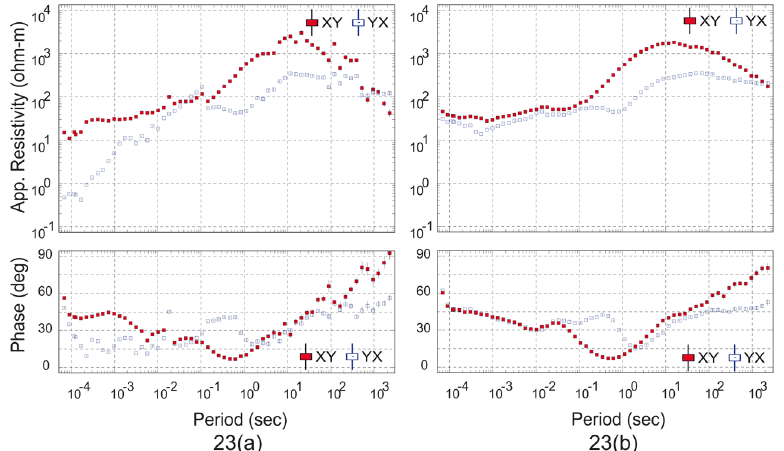
Figure 23. Comparison between processing approaches that are applied on broad band MT data of site K11 from Koyna profile. (a) Result (apparent resistivity (top panel) and phase (bottom panel) curves) obtained from a single processing method (Selective Stacking) with a sin- gle set of processing parameters. (b) Result (apparent resistivity (upper panel) and phase (lower panel) curves) obtained from a combination of processing methods with combinations of different sets of processing parameters which indicates a better output while processing cul- turally affected noisy data. The red colored boxes represent XY components and the blue colored boxes represent YX components of apparent resistivity and